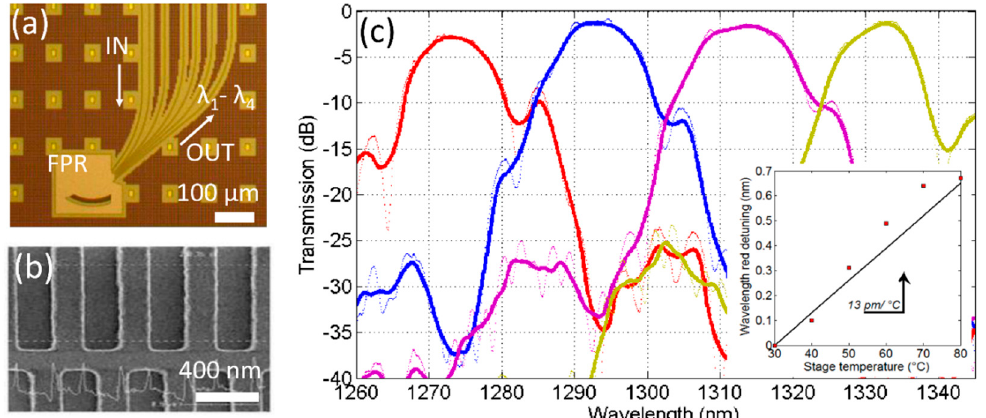
Figure 3. Optical ( a ) and scanning electron microscope (SEM) ( b ) images of the CWDM echelle grating (de)-multiplexer realized on 200-mm SiNOI platform. Close-up SEM pictures of the DBR-assisted facets used to improve the grating reflectivity. ( c ) Transmission spectrum of the 20-nm-spaced 4-channels echelle grating de-multiplexer across the O-band. Raw data (dashed line) and fitted plot (solid lines). (inset) Wavelength red detuning between 30 °C and 80 °C reveals a thermal dispersion coefficient of 13 pm/°C.